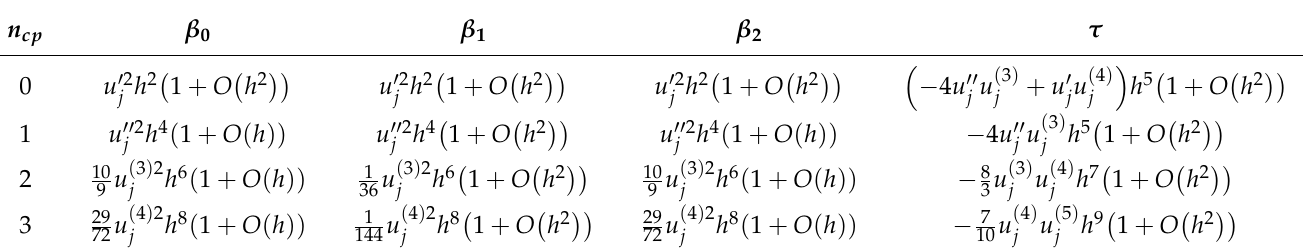
Table 1. Taylor series expansion of β k and τ for